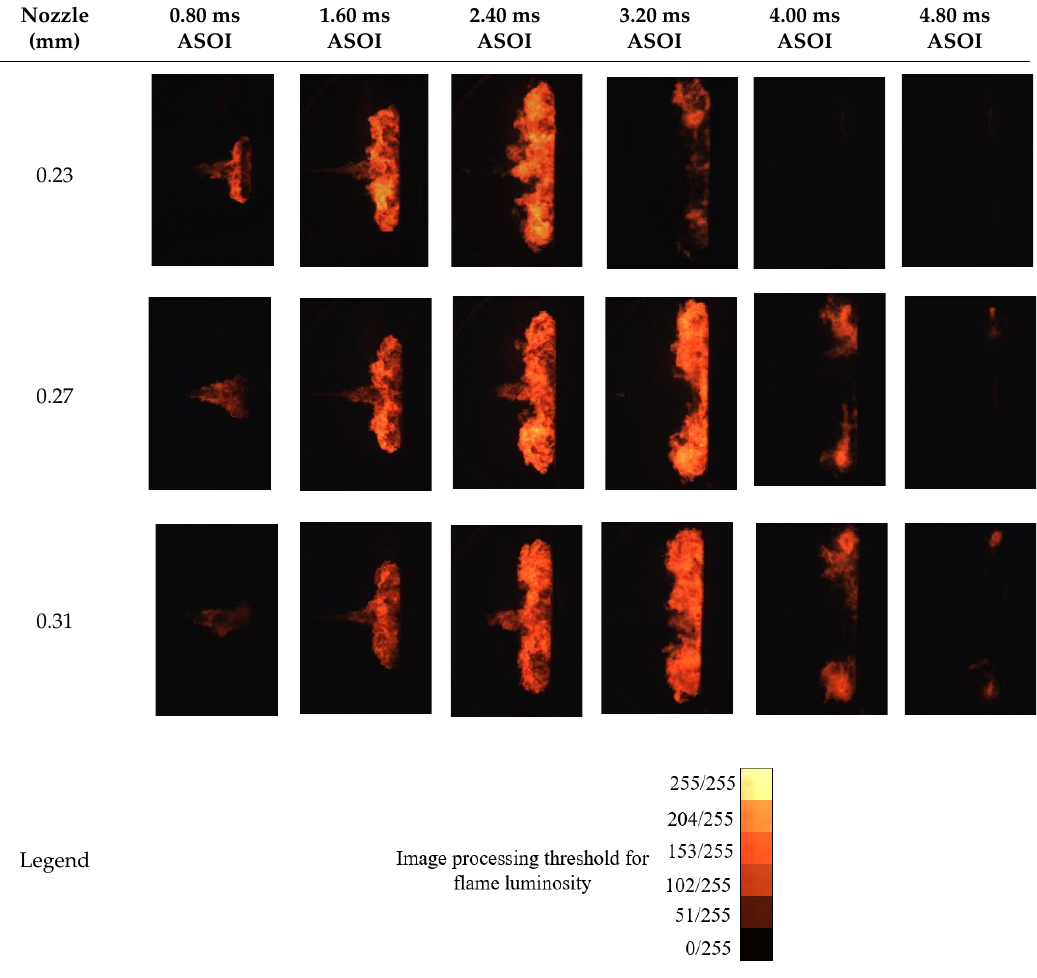
Table 7. Image of impinging diffusion Table 7. Image of impinging diffusion flame. Table 7. Image of impinging diffusion flame. Table 7. Image of impinging diffusion flame. Table 7. Image of impinging diffusion flame. Table 7. Image of impinging diffusion flame. Table 7. Image of impinging diffusion flame. Table 7. Image of impinging diffusion flame. Table 7. Image of impinging diffusion flame. Table 7. Image of impinging diffusion flame. Table 7. Image of impinging diffusion flame. Table 7. Image of impinging diffusion flame. Table 7. Image of impinging diffusion flame. Table 7. Image of impinging di ff usion flame. Table 7. Image of impinging diffusion flame. Table 7. Image of impinging diffusion flame. Table 7. Image of impinging diffusion flame. Table 7. Image of impinging diffusion flame. Table 7. Image of impinging diffusion flame. Table 7. Image of impinging diffusion flame.